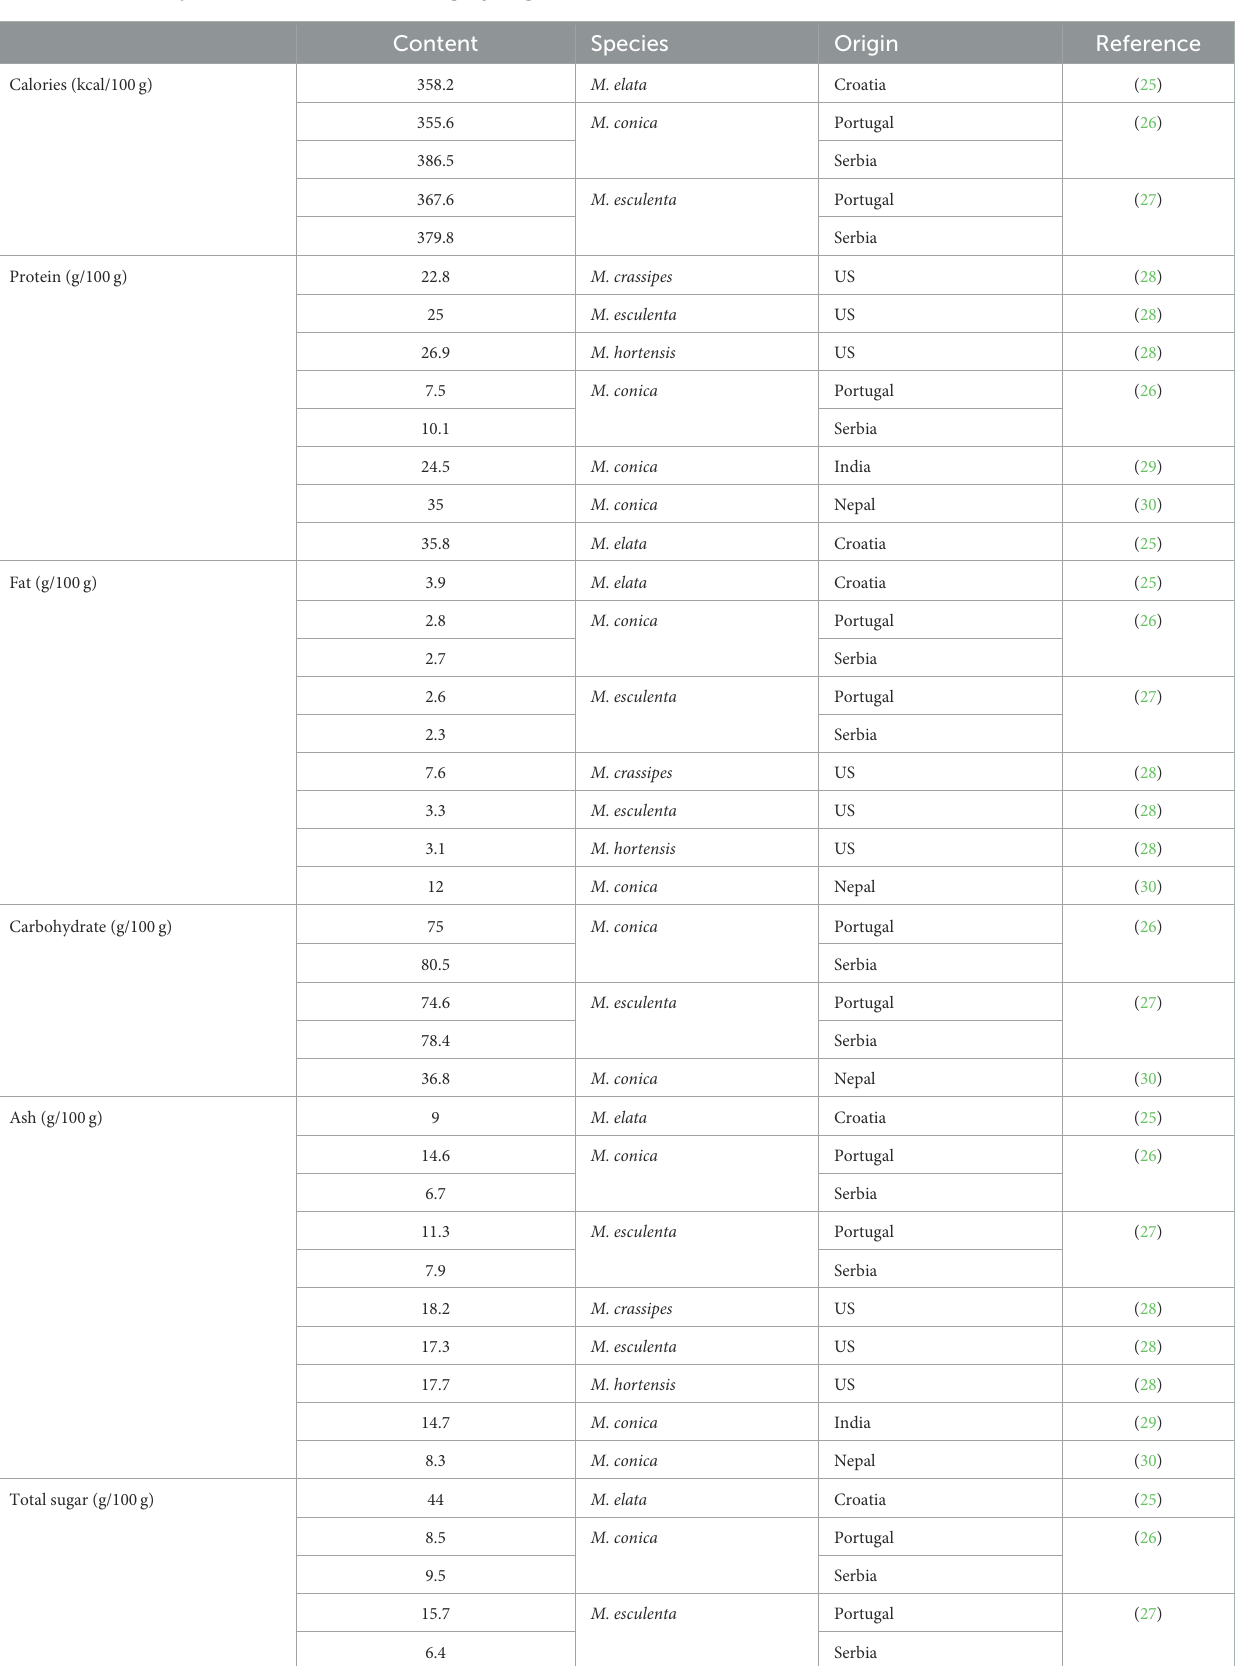
TABLE 3 Nutrient composition of morels (based on 100g dry weight).